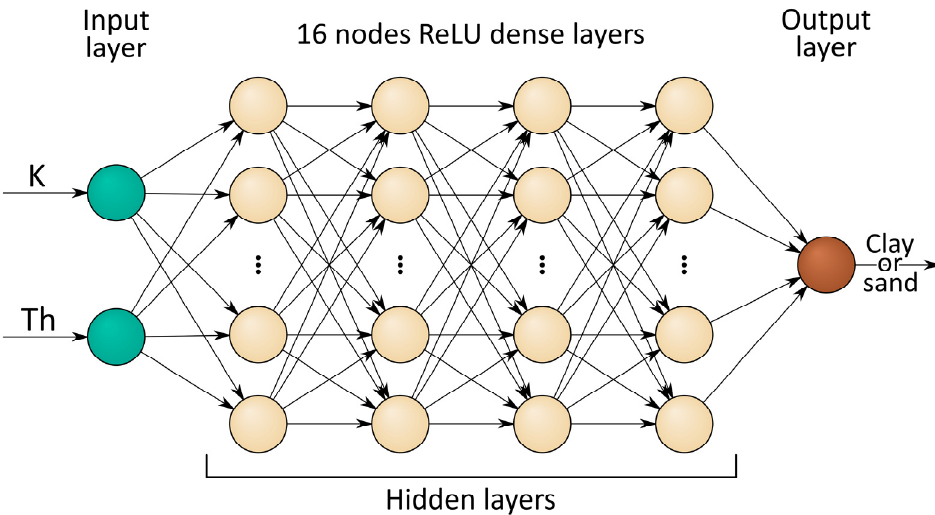
Figure 3. Deep neural network model diagram for predicting the output (clay or sand weight fraction) starting from the input features (K and Th abundances). The hidden layers include four dense (fully connected) layers with 16 nodes activated by the ReLU function.